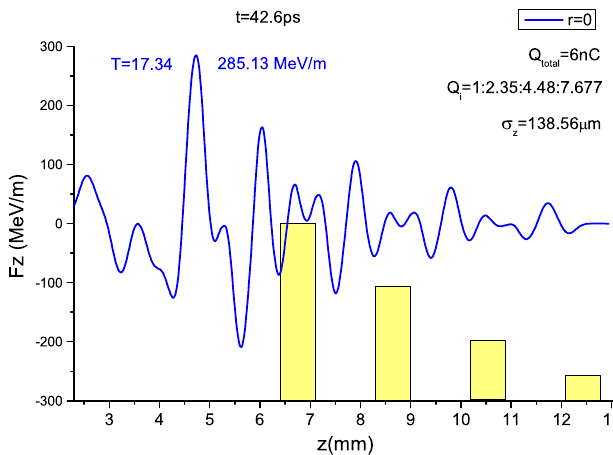
FIG. 9. Wakefield amplitude buildup from a four-drive bunch RBT in a THz CDWA. The bunch energy is 5 GeV, and the total , T , and charge ratios are displayed charge Q , bunch rms size (cid:1) z on the graph. The head of the first drive bunch is located at z ¼ 12 771 (cid:2) m . The bunch spacing is approximately 1890 (cid:2) m ¼ 139 (cid:2) m . The bunches and the bunch length parameter is (cid:1) z move from left to